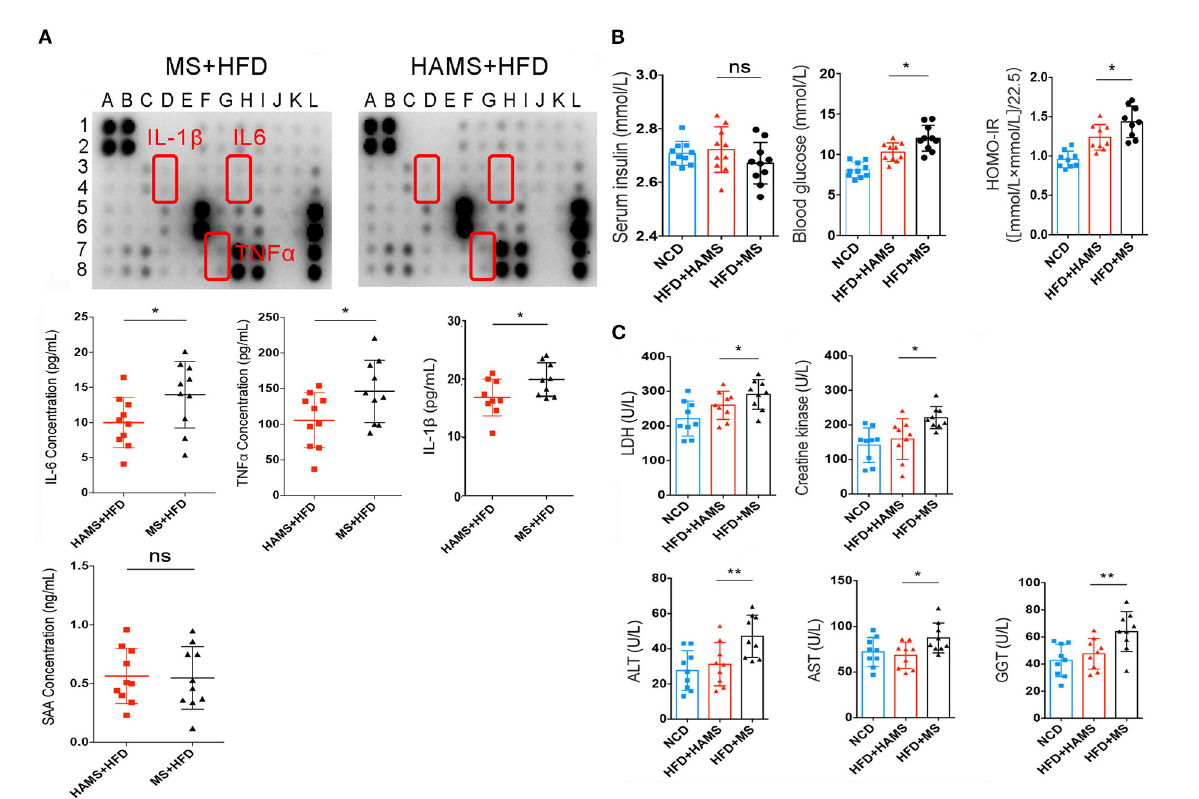
FIGURE5 HAMS improves gut barrier function and reduces the systemic inflammatory response. (A) Inflammatory factor antibody array and ELISAs were both used to detect the expression of inflammatory factors in serum ( n = 10 biologically independent animals per group, the data are presented as the median ± SEM, * P < 0.05, Student’s t -test. N = 10 for NCD are also shown). Detailed information on the inflammatory factors can be seen in Supplementary Table 1. (B) Serum insulin, blood glucose, and HOMA-IR were all analyzed ( n = 10 biologically independent HAMS animals vs. n = 10MS animals; the data are presented as the median ± SEM, * P ≤ 0.05, one-way ANOVA with Bonferroni post hoc test, n = 10 for NCD are also shown). (C) Organ and tissue damage indicators were all analyzed in the NCD, HAMS, and MS groups ( n = 9 biologically independent animals per group, the data are presented as the median ± SEM, * P < 0.05, ** P < 0.01, one-way ANOVA with Bonferroni post hoc test. N = 9 for NCD are also